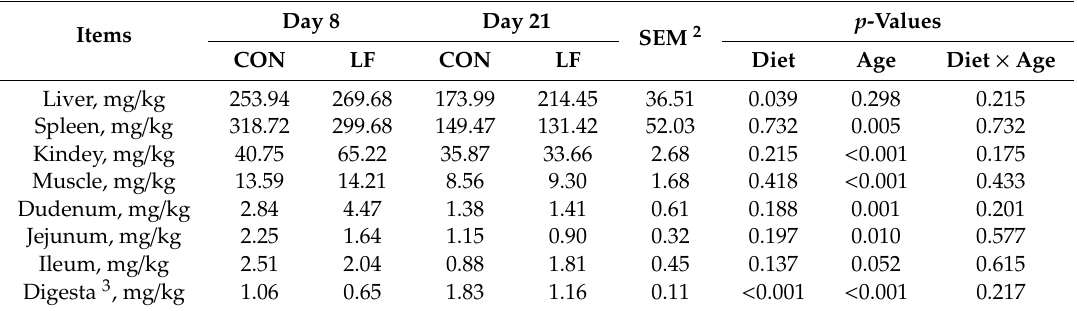
Table 3. E ff ects of lactoferrin on the iron concentrations in the tissues and digesta of suckling piglets 1